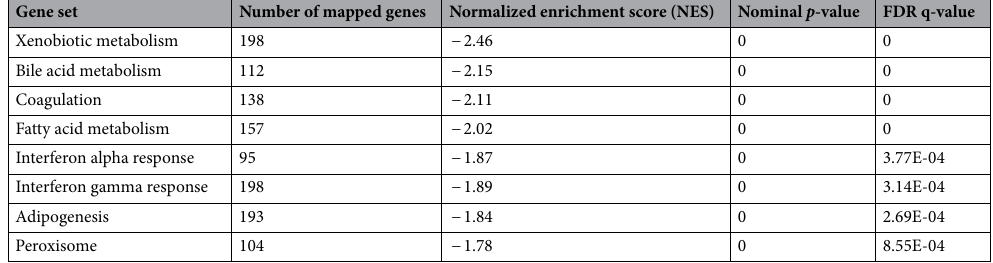
Table 2. Most downregulated gene sets in developing liver compared to adult liver stage using the Molecular Signatures Database hallmark gene set in Gene Set Enrichment Analysis (GSEA). FDR, False